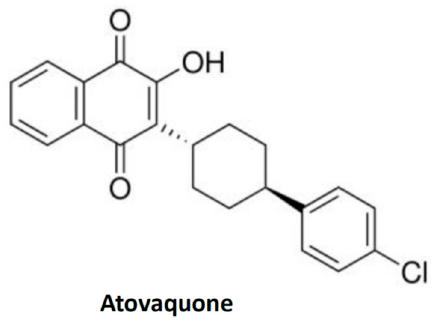
Figure 1. Structure of quinone-based compound, atovaquone. The structure is taken from the public repository PubChem structure for CAS 95233-18-4.